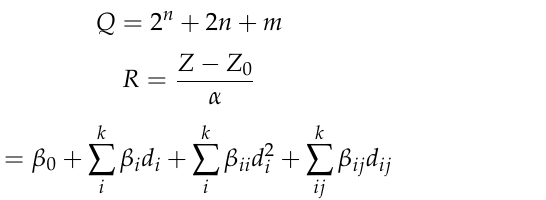
Table 1. The suggested design array of experimental work based on FC-CCD.